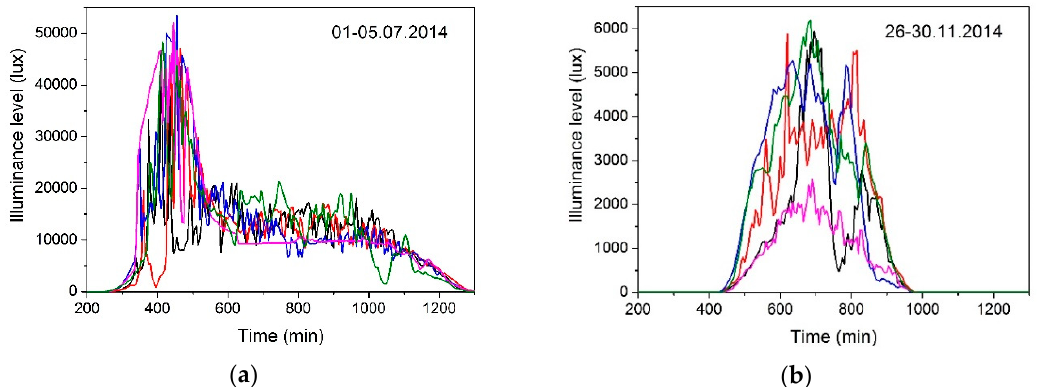
Figure 6. Daylight illuminance level recorded by the brightness sensor mounted on the north facade of the building ( a ) from 1 July 2014 to 5 July 2014 and ( b ) from 26 November 2014 to 30 November 2014.